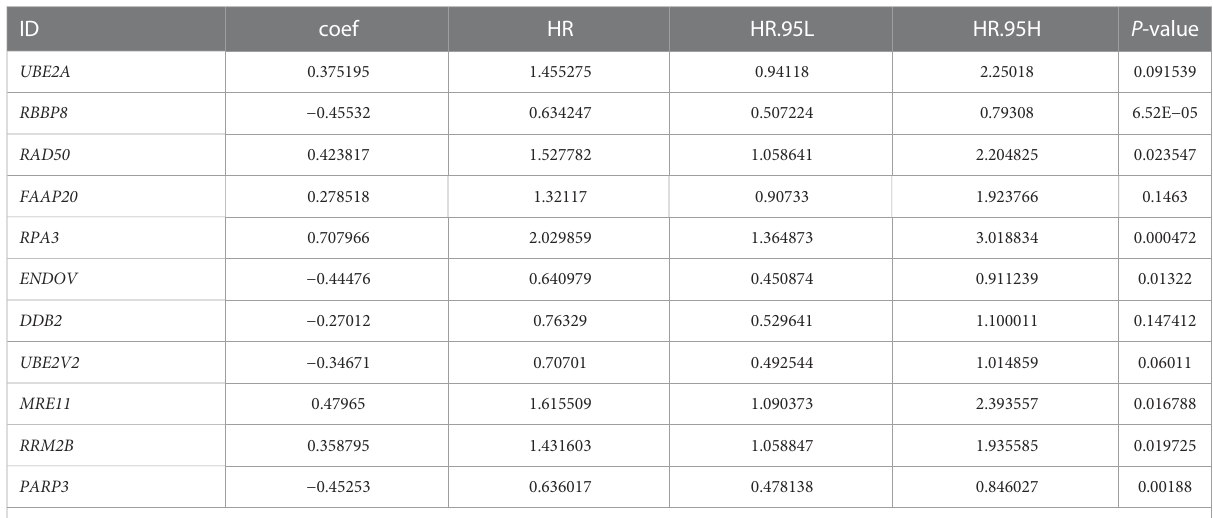
TABLE 2 Prognosis-related DNA repair